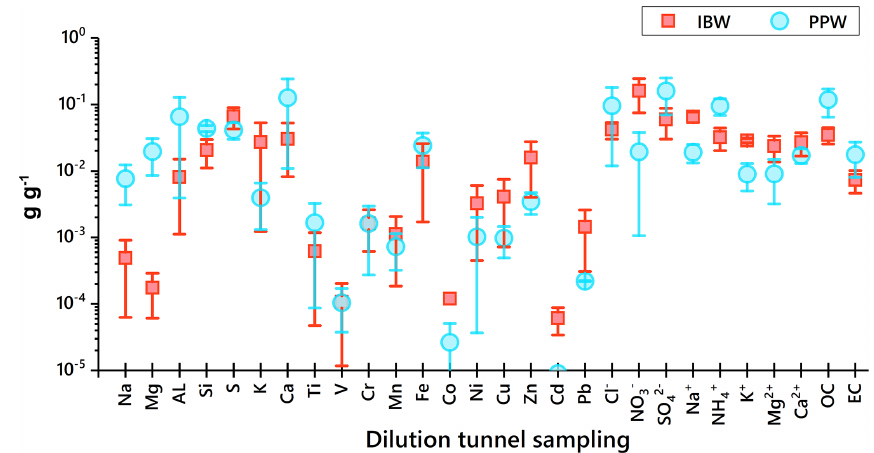
Figure 5. The means and standard deviations of chemical species in the source profiles of coal-fired industrial boilers equipped with wet desulfurization devices (IBW) and power plant boilers equipped with wet desulfurization devices (PPW), respectively. Data were collated from the Nankai University source library.